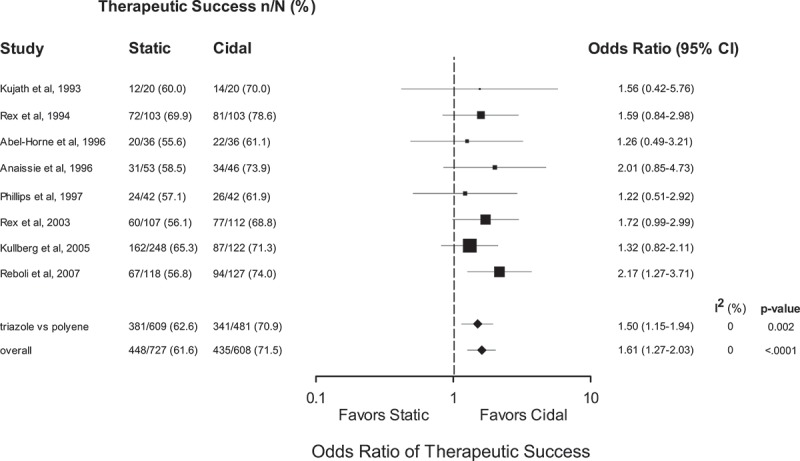
Therapeutic success at end of therapy for trials comparing fungicidal and fungistatic therapy of invasive candidiasis and/or candidemia. Odds ratios (ORs) are pooled using a random-effects model on a logarithmic scale. The size of the squares is proportional to the reciprocal of the variance of the studies. CI: confidence interval, n/N: frequency of finding.